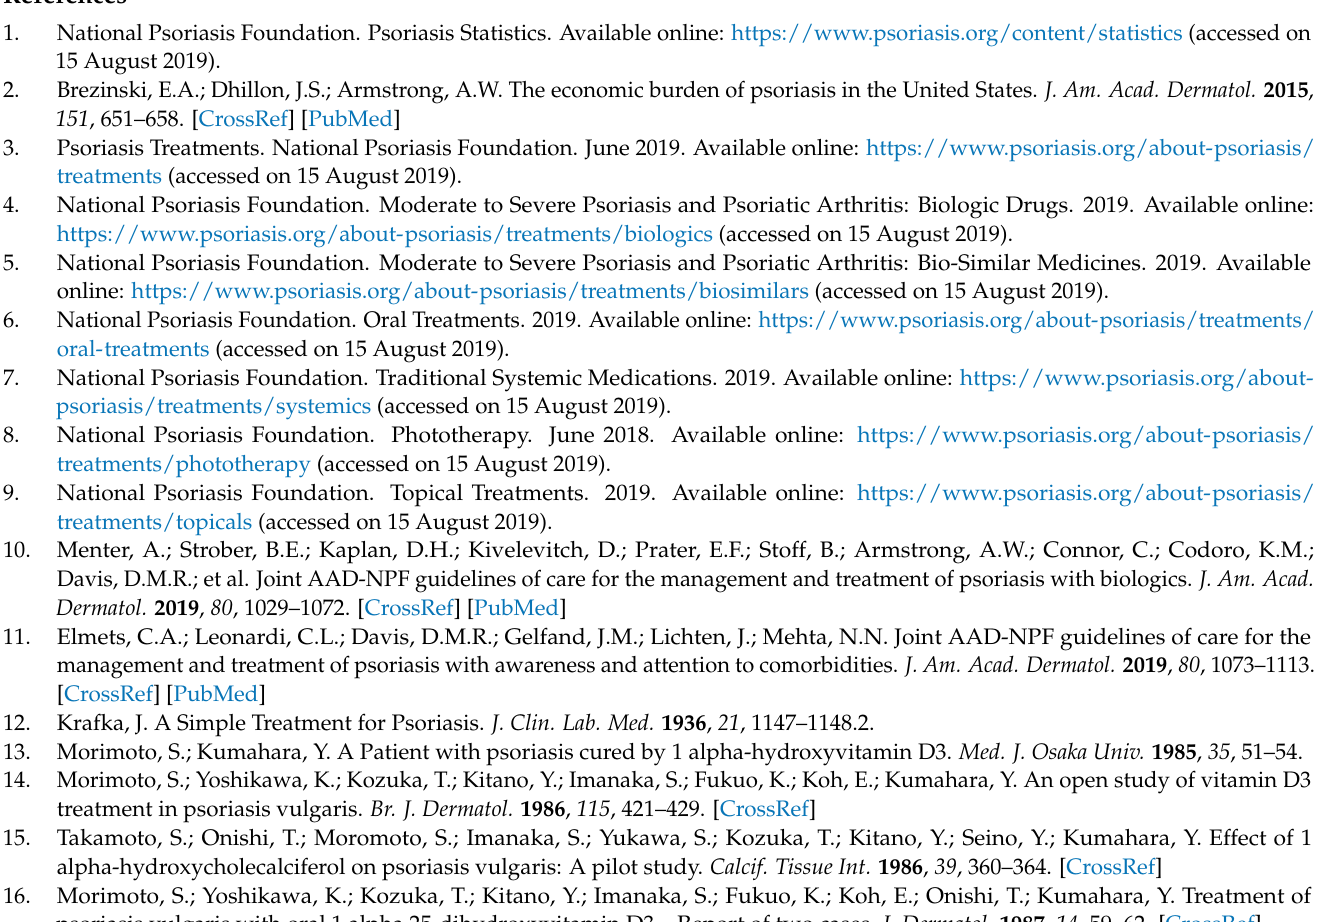
range and distribution of serum 25(OH)D3 concentrations, and mean serum cal-cium and calcitriol concentrations before and after UVB phototherapy in 13 patients with plaque psoriasis also treated with placebo (n = 7) or calcitriol (n = 6). Table S7. Range, median and distribution of serum 25(OH)D3 Table S8. Mean, range and distribution of serum 25(OH)D3 concentrations before and after BB-UVB (n = 26) and NB-UVB (n = 42) phototherapy in 68 patients with psoriasis. Table S9. Mean, range and distribution of serum 25(OH)D3 concentrations pre-and post 8-12 weeks of BB-UVB phototherapy (n = 24 postmenopausal women) or 15 days of whole-body sun-shine (n = 20) exposure in 44 patients with plaque